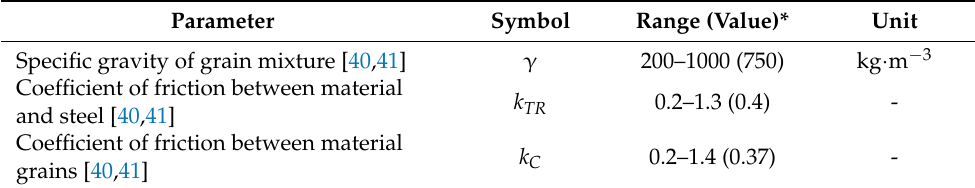
Table 2. Material properties used in calculations.